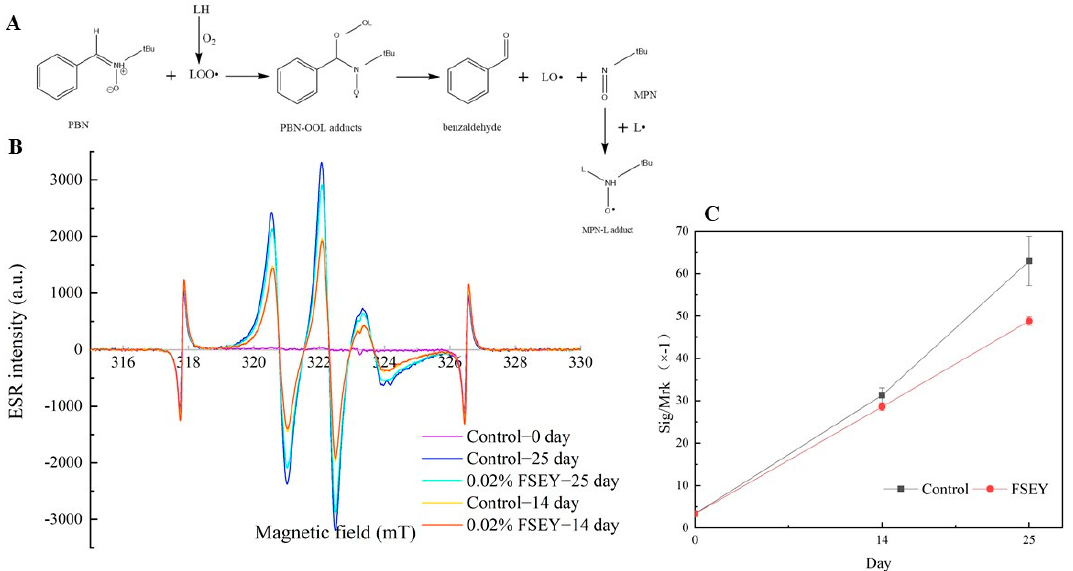
Figure 3. ( A ) Mechanisms of the interaction of PBN with lipid radicals and the fate of its products in emulsions. ( B ) Evolution of peak-to-peak amplitude of spin adducts after heated storage (37 ◦ C for 25 days). ( C ) Evolution of the radical relative intensity (signal/marker) during the accelerated oxidative process. Values are expressed as mean ± SD ( n = 2).